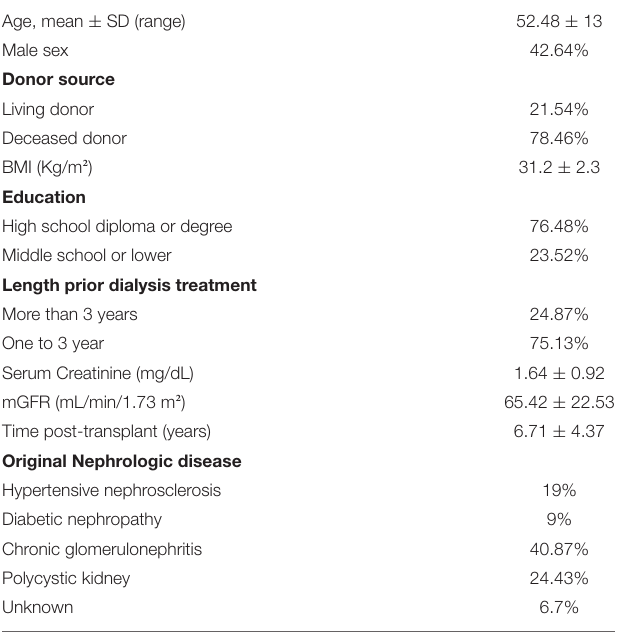
TABLE 1 | Demographic characteristics of patients included in the